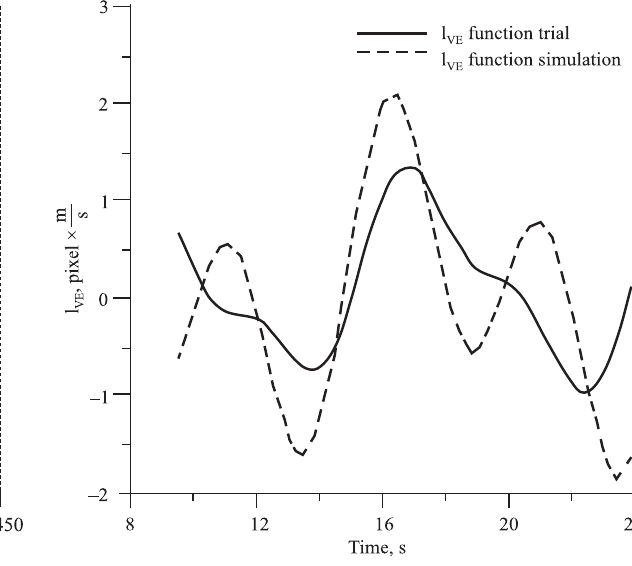
Fig. 11. Comparison of the Intensity of Visual Energy in relationship with the time between the original and simulated scenarios in the section 200 – 450